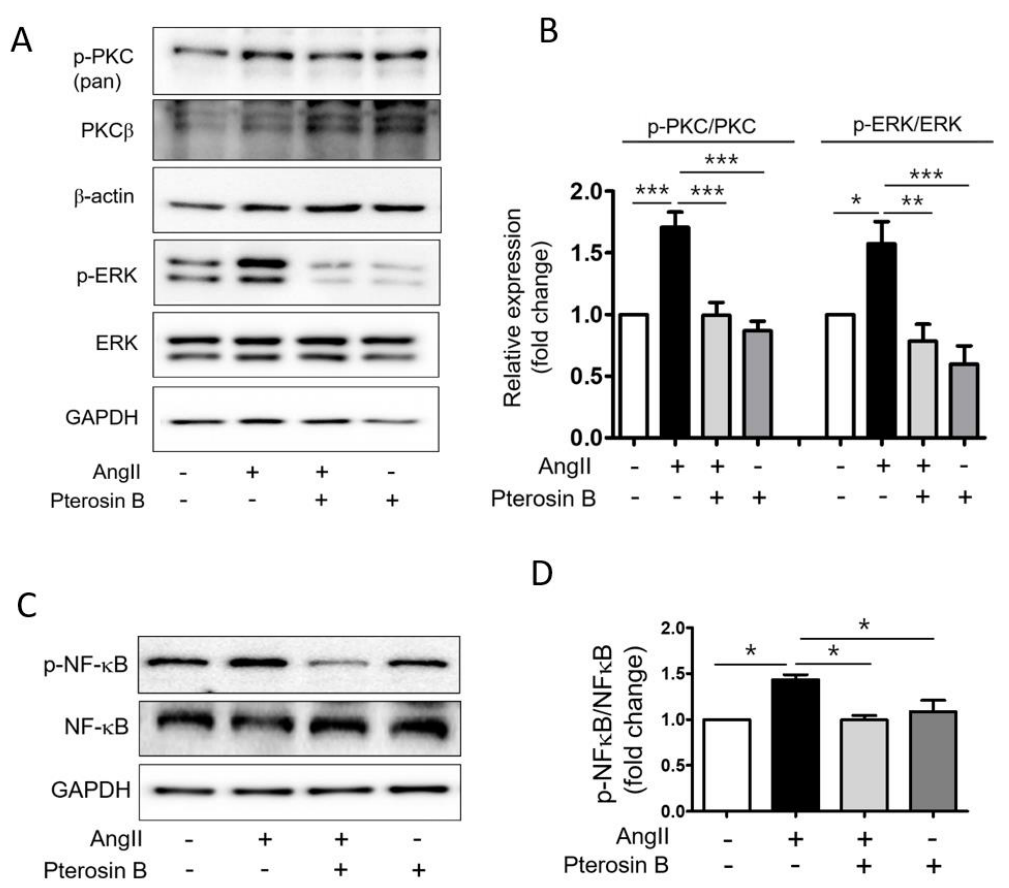
Figure 4. Pterosin B attenuates PKC-ERK activation in Ang II-induced cardiomyocyte hypertrophy.